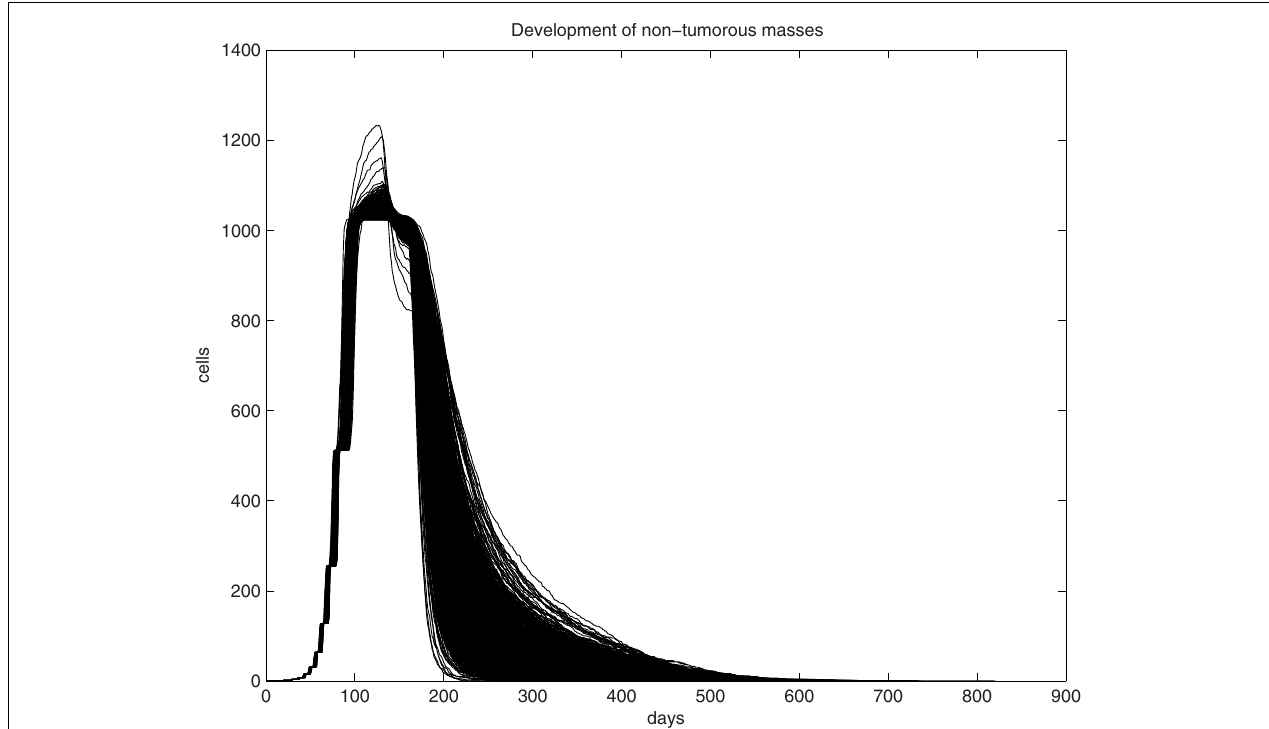
FIGURE 1 | Graphic illustration of trajectories for the number of living cells within a clone and its lifespan (days) over time. One-thousand trajectories, each as the result of clonal expansion from a single progenitor cell, are shown.